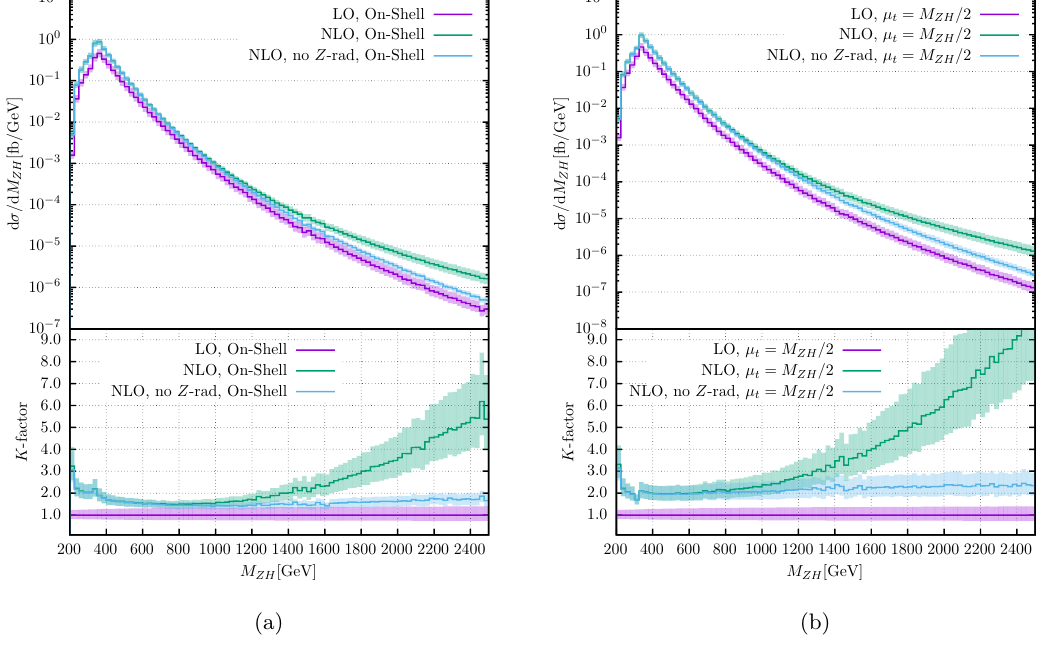
Figure 4. Invariant-mass distribution at LO (magenta) and NLO (green) for the OS scheme (a) and the MS scheme (b) for a wide M ZH range. The NLO results in which the Z -radiated diagrams are excluded are shown in blue. The lower panels show the K